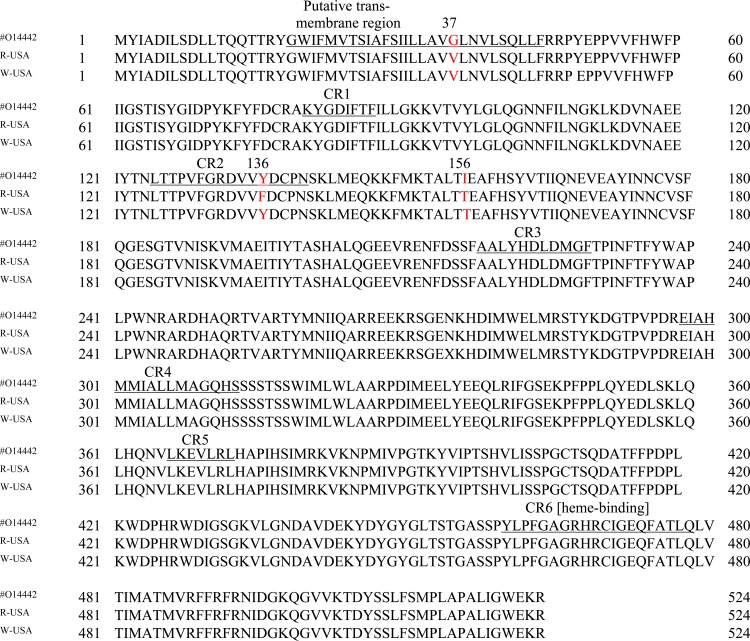
Alignment of the consensus amino acid sequence of CYP51 of Erysiphe necator isolates from the United States, with Y136F (R-USA) and without Y136F (W-USA) with the CYP51 (UniProtKB/Swiss-Prot Accession no. O14442) of an E. necator isolate from Europe, which is based on a Group B isolate [49].Conserved domains are underlined in the European sequence as proposed by Délye et al. [24]. Amino acids in red indicate a variation from at least one other sequence.